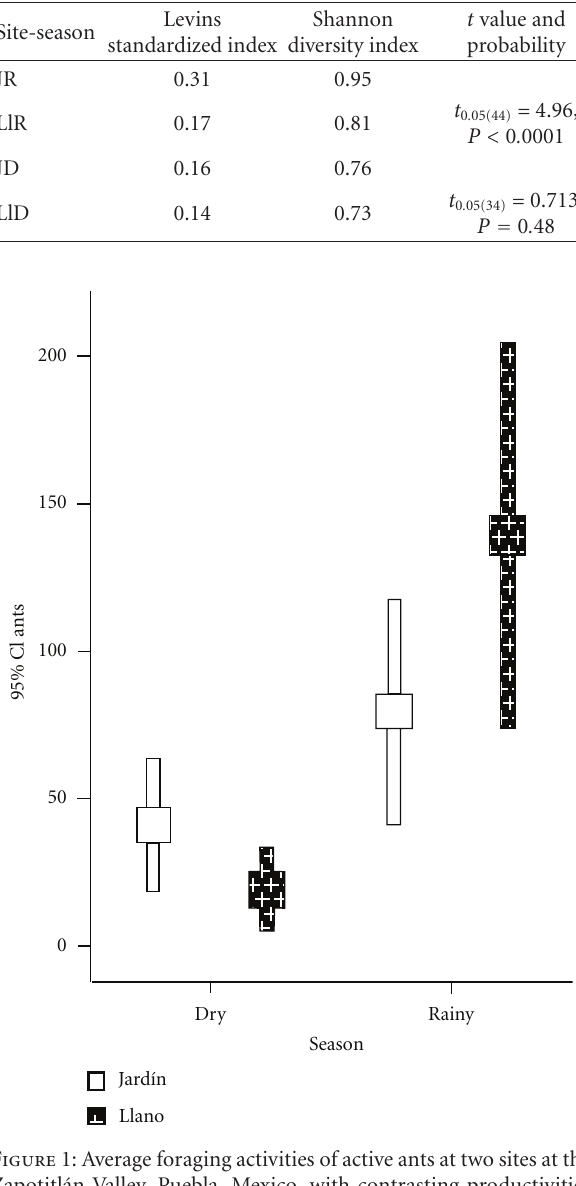
Figure 1: Average foraging activities of active ants at two sites at the Zapotitl´an Valley, Puebla, Mexico, with contrasting productivities during two